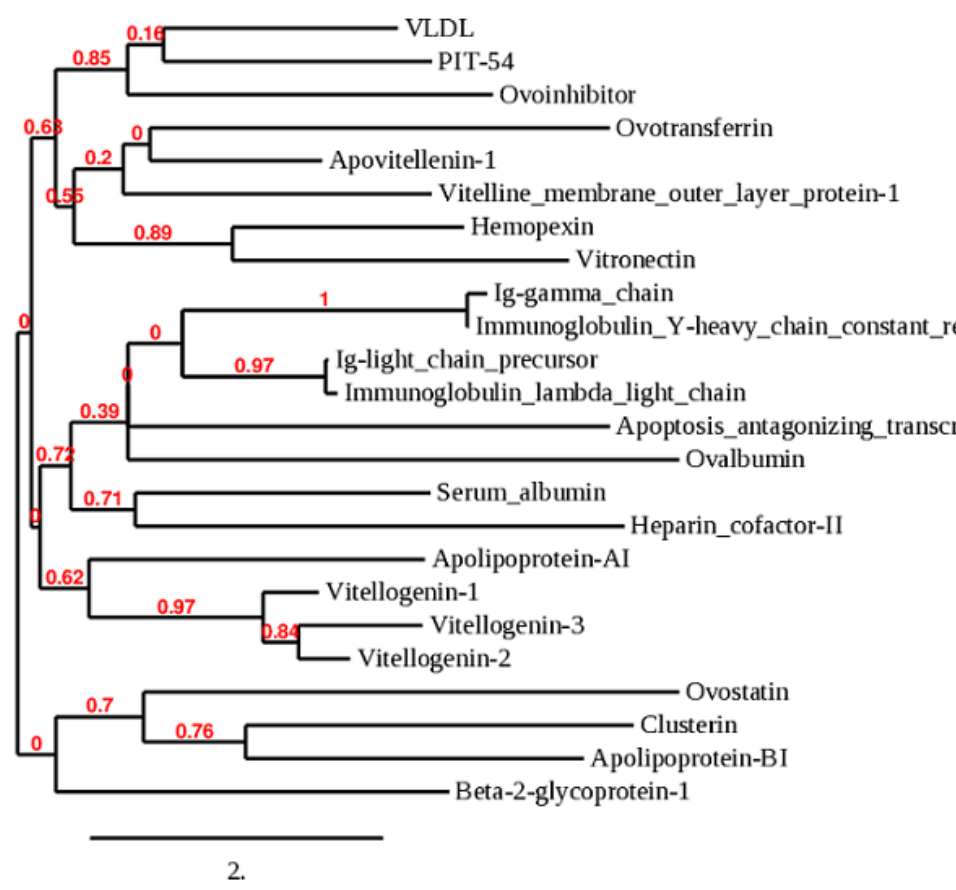
Figure 2. The phylogenetic tree was constructed to check the proximity of detected egg yolk proteins. The vitellogenin proteins (VTG-1, VTG-2, and VTG-3) showed close resemblance and attached in a branch with apolipoprotein-1. Ovotransferrin is associated with apovitellenin-1, serum albumin formed a clade with heparin cofactor-II, ovoinhibitor showed proximity with PIT-54, and vitelline membrane outer layer protein-1 connected with ovotransferrin. The nodes and branch lengths are indicated.